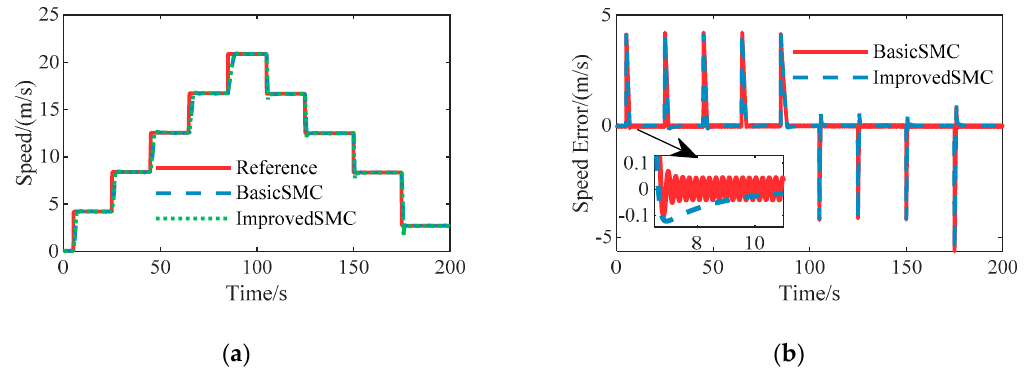
Figure 5. System responses to stair step reference speed on the straight road: ( a ) Speed tracking results; ( b ) Speed tracking error.